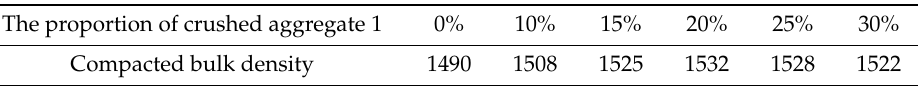
Table 5. The compacted bulk density of the coarse aggregate mixture (kg / m 3 ).